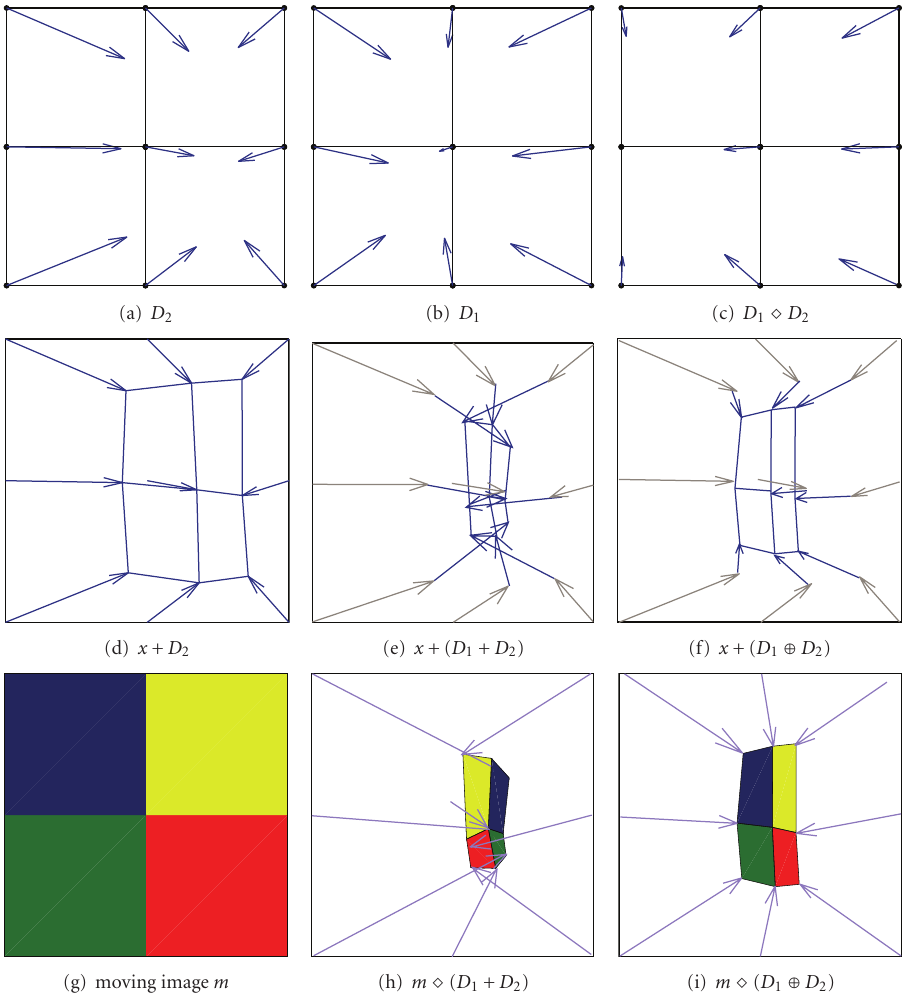
Figure 1: Comparison between additive and compositive field accumulations.Warping is implemented using linear interpolation. In (a) and (b), two di ff erent displacement fields are defined on the plane (for visual clarity). In (c), the field D 1 warped by D 2 , that is, D 1 (cid:7) D 2 = D 1 ◦ Δ 2 . In (d), the field D 2 is applied on the pixel grid. In (e), the grid is warped by the field resulting from an addition-based accumulation of D 1 and D 2 . In (f), the grid is warped by the displacement field D 1 ⊕ D 2 arising by the composition of Δ 1 and Δ 2 , which is the sum of the dark blue and gray arrows (given by Δ 1 ◦ Δ 2 − Id). This composition is really the accumulation that matters since it corresponds to the way displacement fields are iteratively applied to an image (see Section 3). Since D 1 ⊕ D 2 = D 2 + D 1 (cid:7) D 2 , the summed vectors in (f) correspond to the vectors in (a) and (c). In (g), a moving object m , divided in 4 colors (regions between pixel centers). In (h), the result of the warping of m by the sum of the fields. Clearly, the surfaces are inverted (mirror e ff ect, visible because of the inversion of colors), leading to nonphysical deformations (negative Jacobians). In (i), the result of the warping of m by the composition of the fields. One can notice that in spite of the deformation of the shape of the object, the location of the colors is